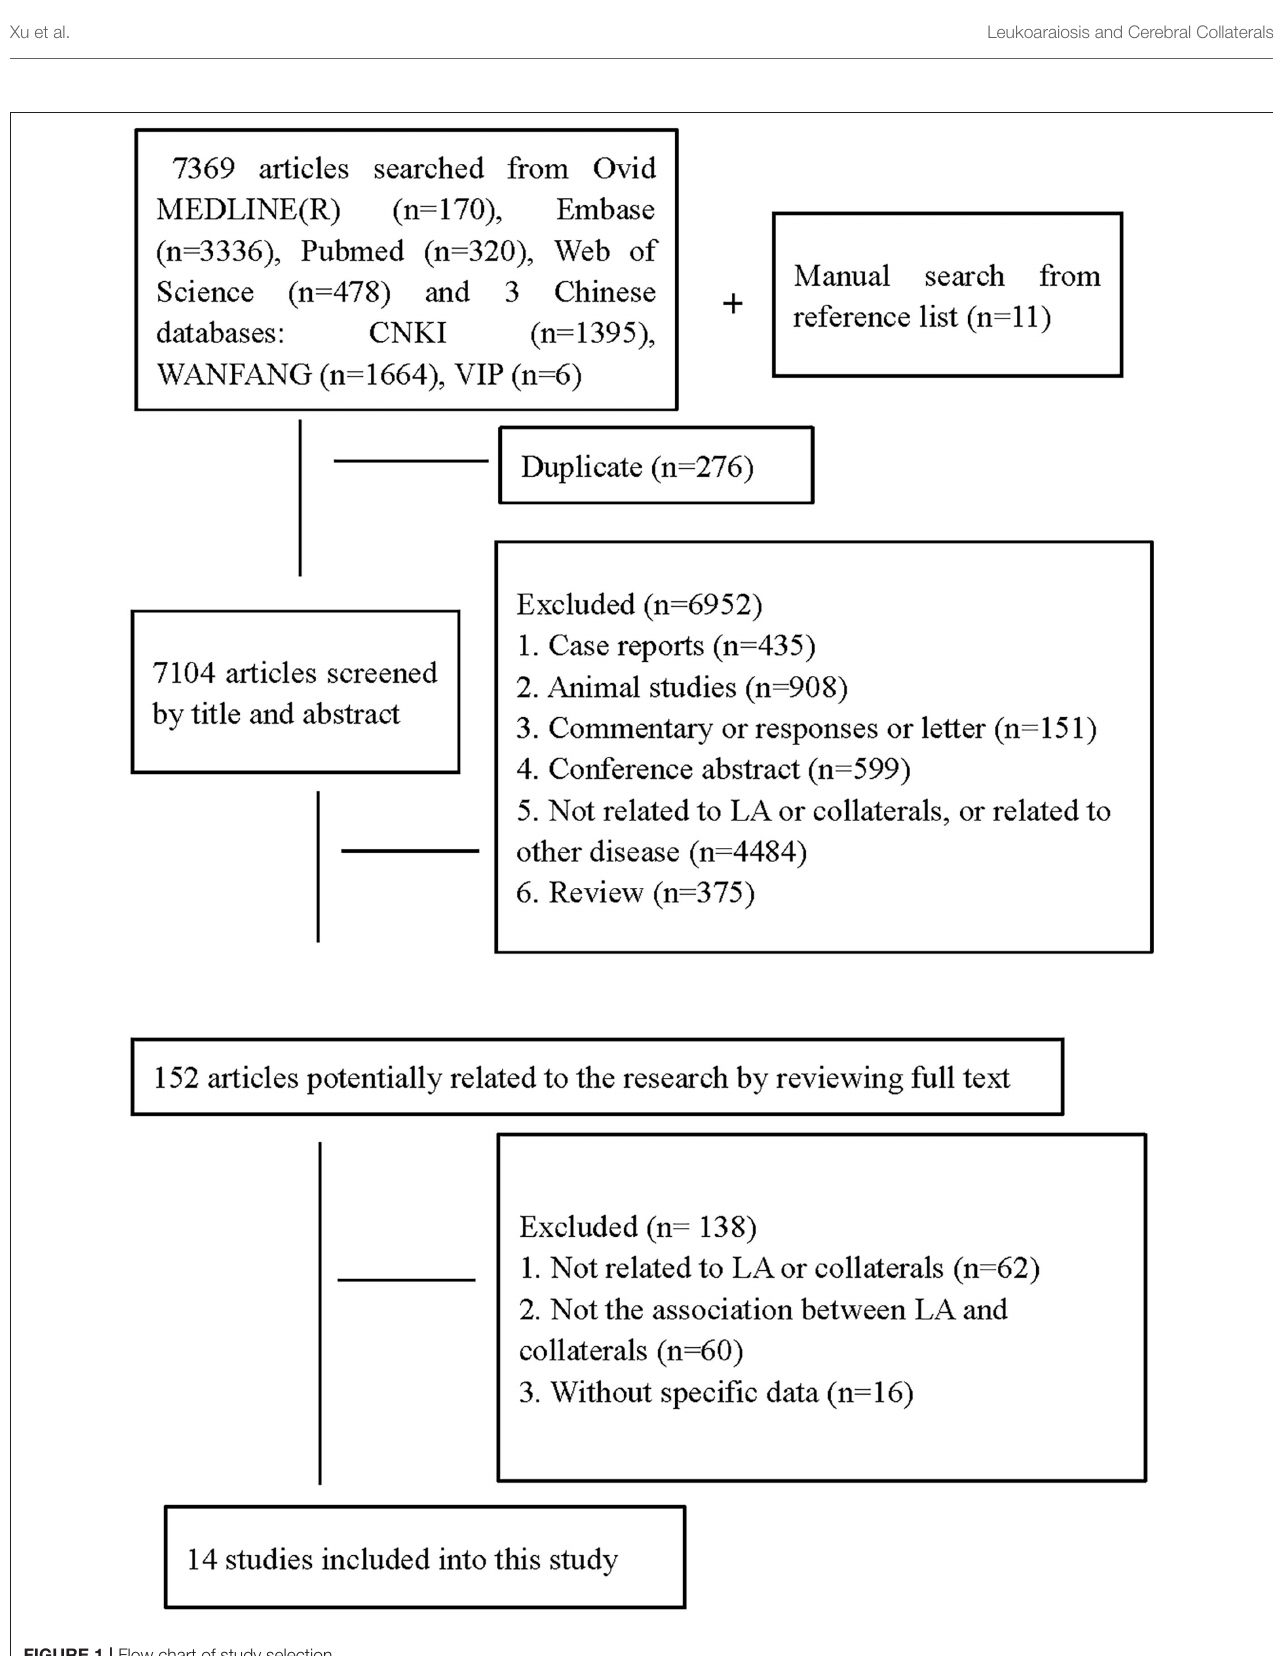
FIGURE 1 | Flow chart of study